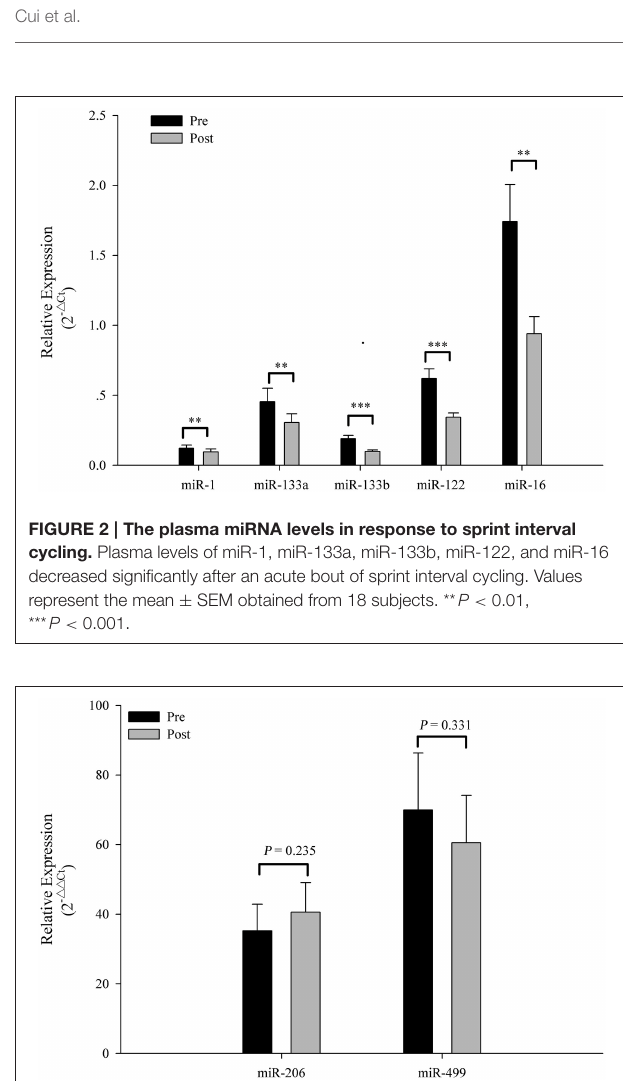
FIGURE 3 | Changes in circulating miR-206 and miR-499 in response to acute exercise. Plasma levels of miR-206 and miR-499 showed no significant difference after an acute bout of sprint interval cycling. Values represent the mean ± SEM obtained from 18